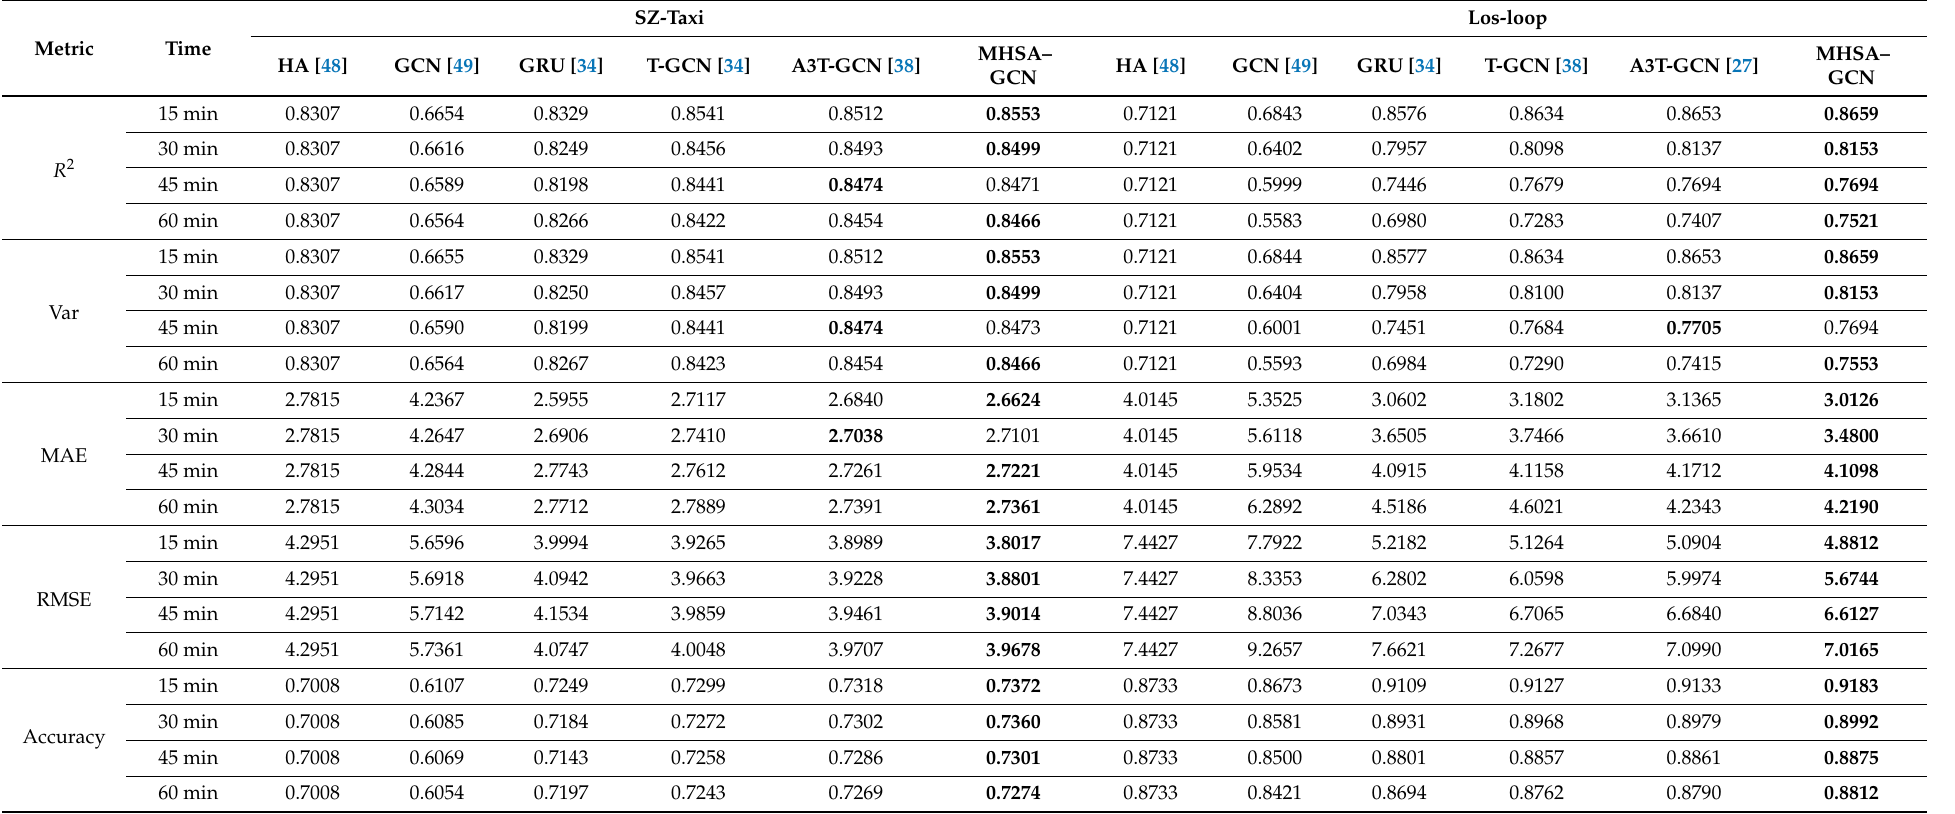
Table 2. MHSA–GCN traffic prediction comparison with other models on SZ-taxi and Los-loop datasets. Higher accuracies are in